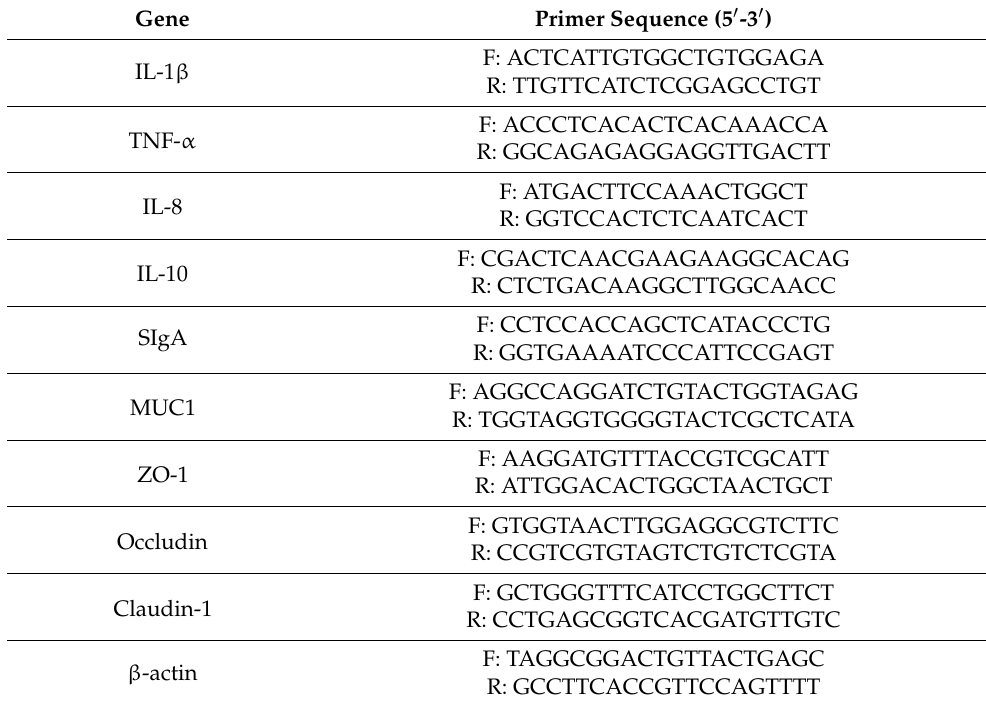
Table 3. Primers for real-time